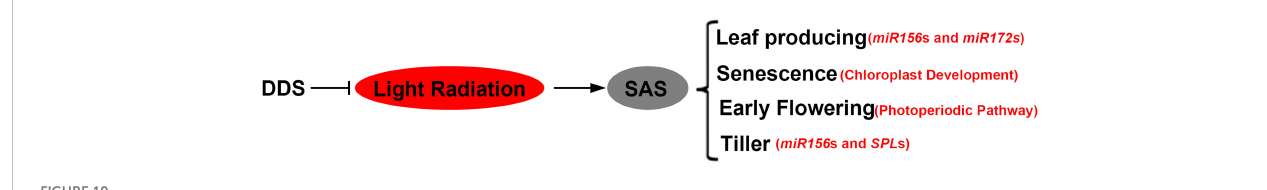
FIGURE 10 Simpli fi ed schematic model depicting the shade-avoidance response in DDS. Arrow: activate; Bar: